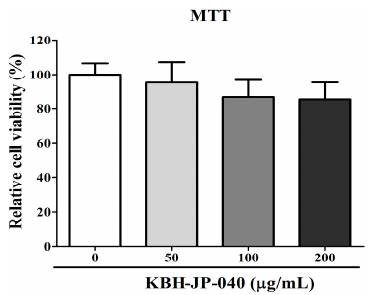
Figure 1. Viability or cytotoxicity test of rat chondrocytes treated with various concentrations of KBH-JP-040 (0, 50, 100, and 200 µ g/mL) for 24 h and analyzed by MTT assay and statistically analyzed by Bonferroni post hoc test following one-way ANOVA versus the normal control (NC) group. No significant changes were observed. All experiments were performed using three